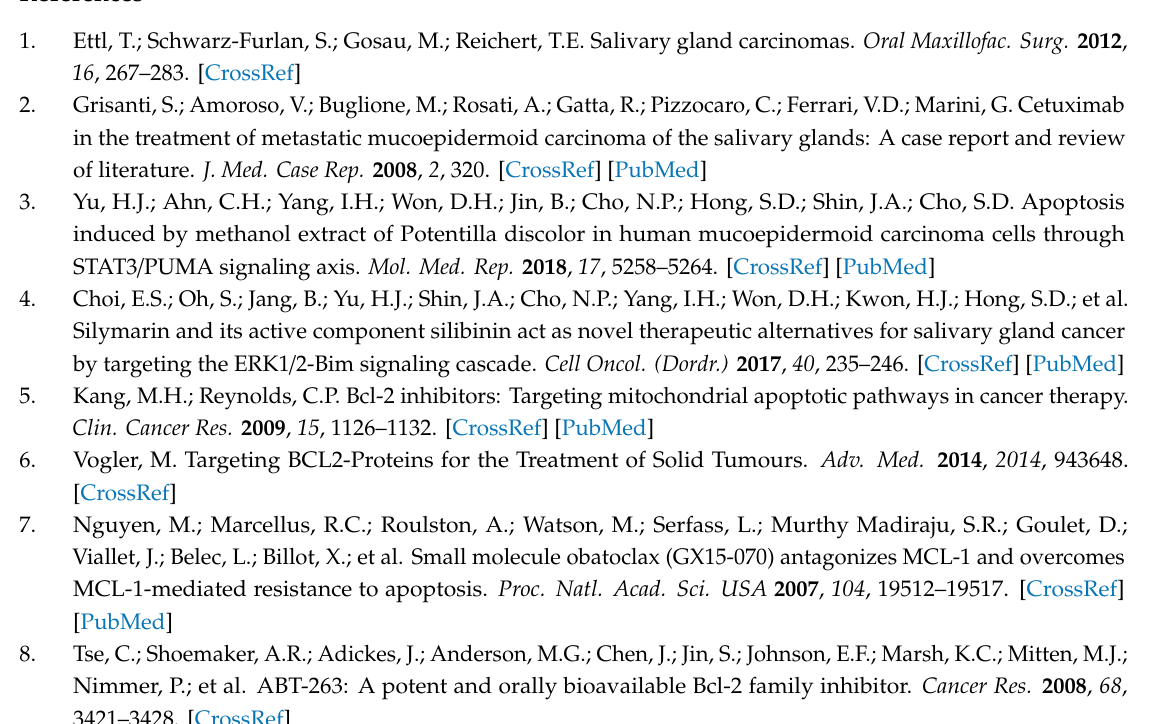
Supplementary Materials: The following are available online, Figure S1: E ff ect of TW-37 on cell cycle arrest of human MEC cells, Figure S2: E ff ect of ectopic expression of HSP27 on TW-37-induced apoptosis, Figure S3: E ff ect of ectopic expression of HO-1 on TW-37-induced